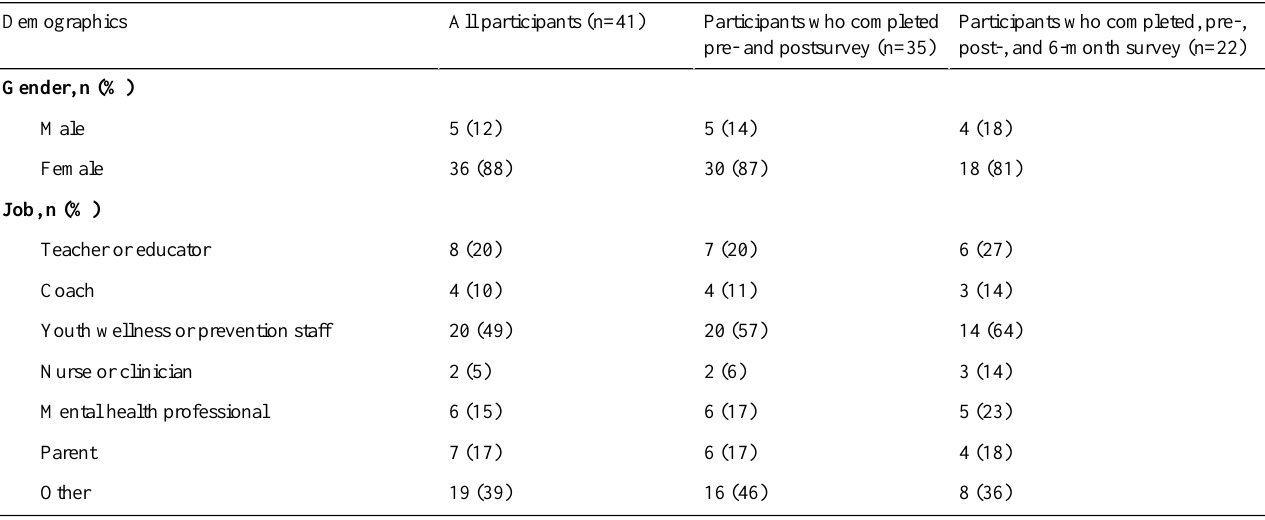
Table 2. Demographic information for tribal health educator participants.